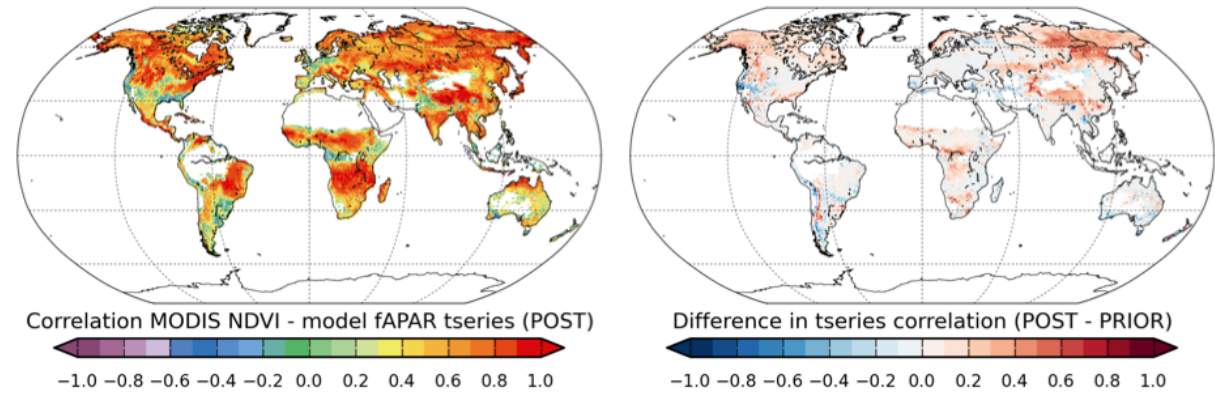
Figure 6. Global maps showing the correlation between the simulated fAPAR and MODIS NDVI data in the weekly time series for the posterior simulation (left column) and the difference after optimisation (posterior – prior) (right column). Note POST refers to the posterior simulation after optimisation, and PRIOR to the simulation using the standard parameters of